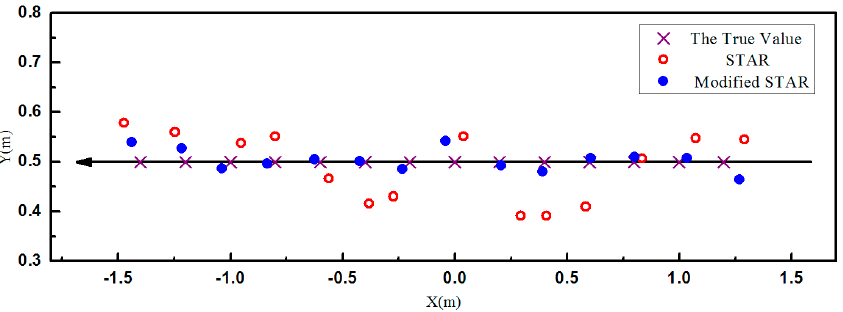
Figure 8. The estimated position of test specimen on the XY plane. Sensors 2016 , 16 , 2168